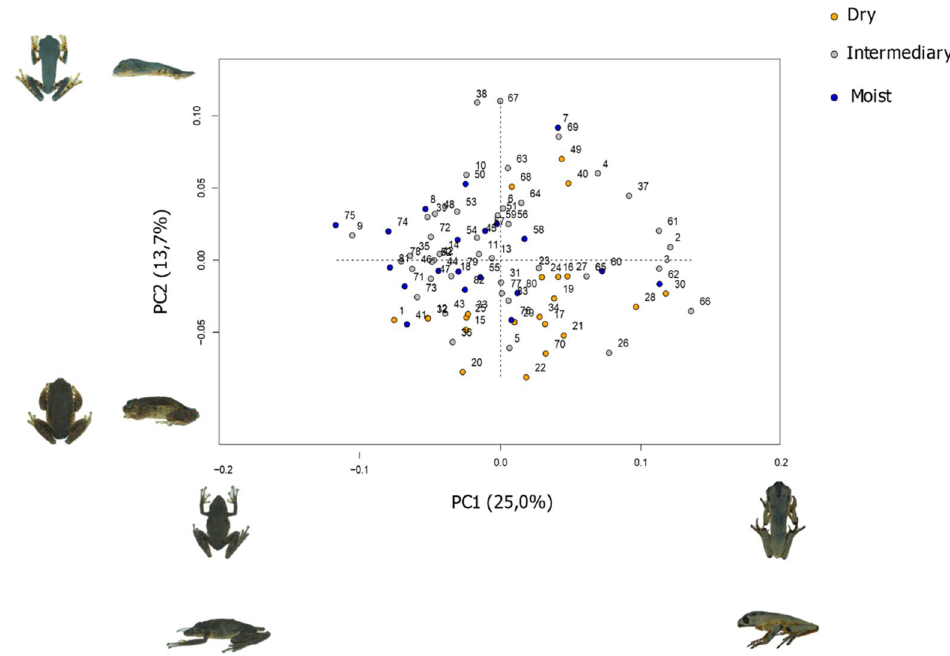
Figure 2. Principal component analysis for the morphospace in Arboranae species. The two axes explain 38.7% of the variation in shape. The horizontal axis is PC1 and the vertical axis is PC2. Colours represent the variation in environmental water availability according to three categories (dry, intermediate, and moist, see text for details). Species on the positive side of PC1 have a shorter snout, whereas species on the negative side display longer snout. Species on the negative side of PC2 have rounder body than species on the positive side. The morphology for each component is to represent by 3D models of Arboranae (PC1 positive: Phyllomedusa